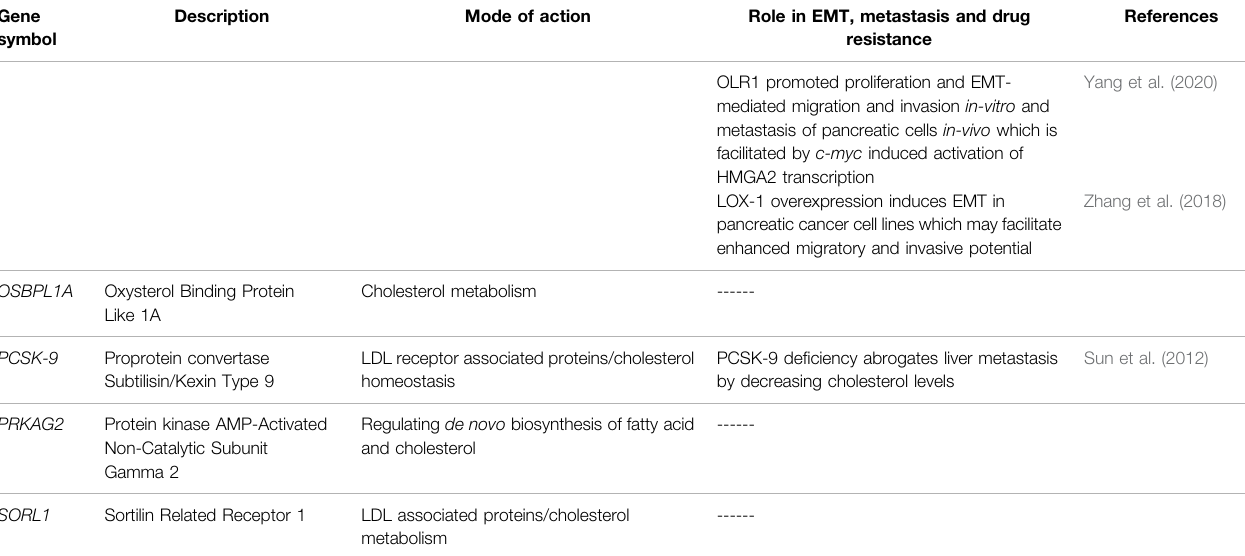
TABLE 1 | ( Continued ) Summary of cholesterol related genes and their link to EMT, metastasis and drug